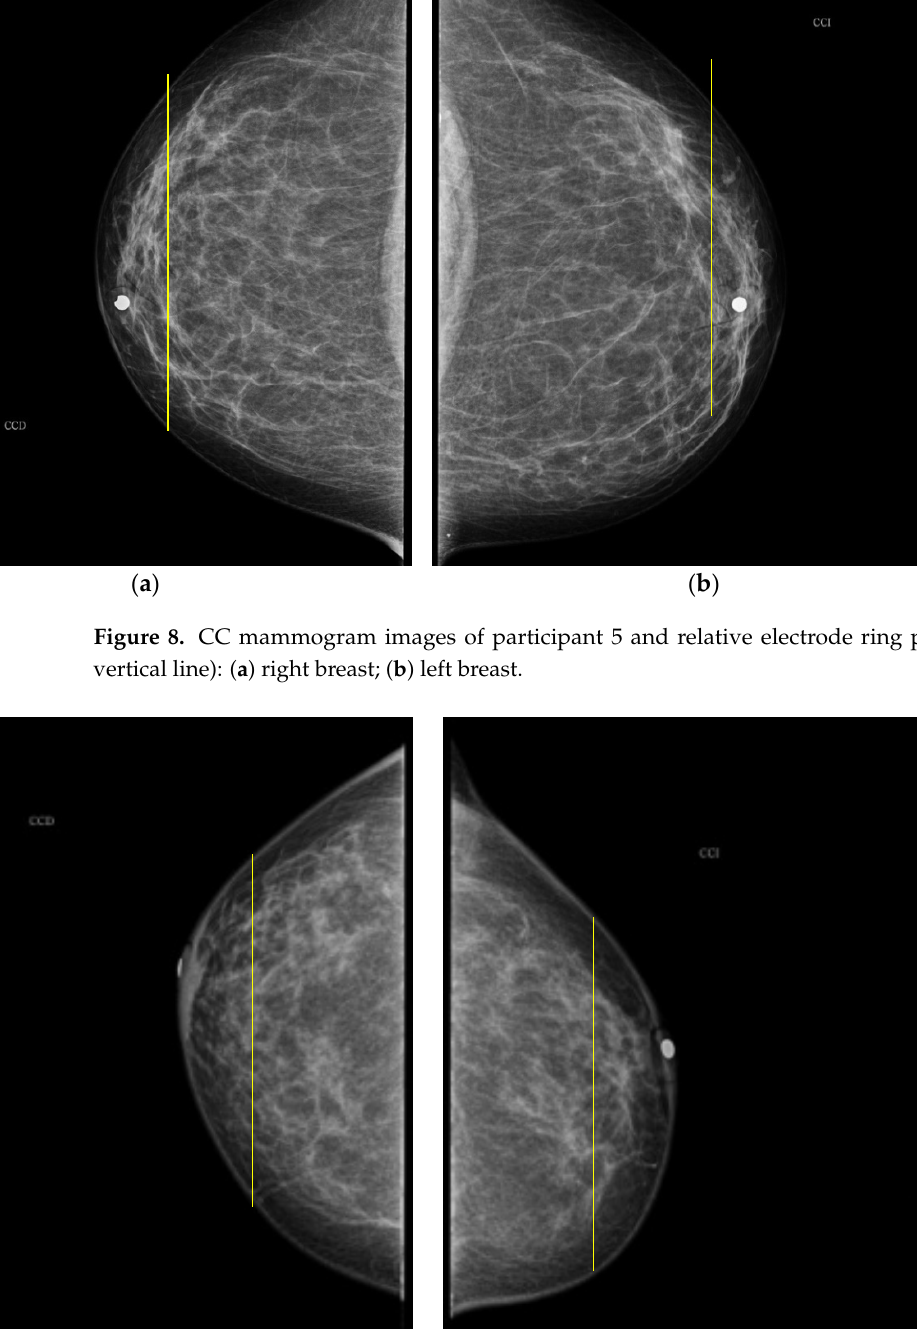
( b ) Figure 10. CC mammogram images of participant 12 and relative electrode ring position (yellow vertical line): ( a ) right breast; ( b ) left breast.